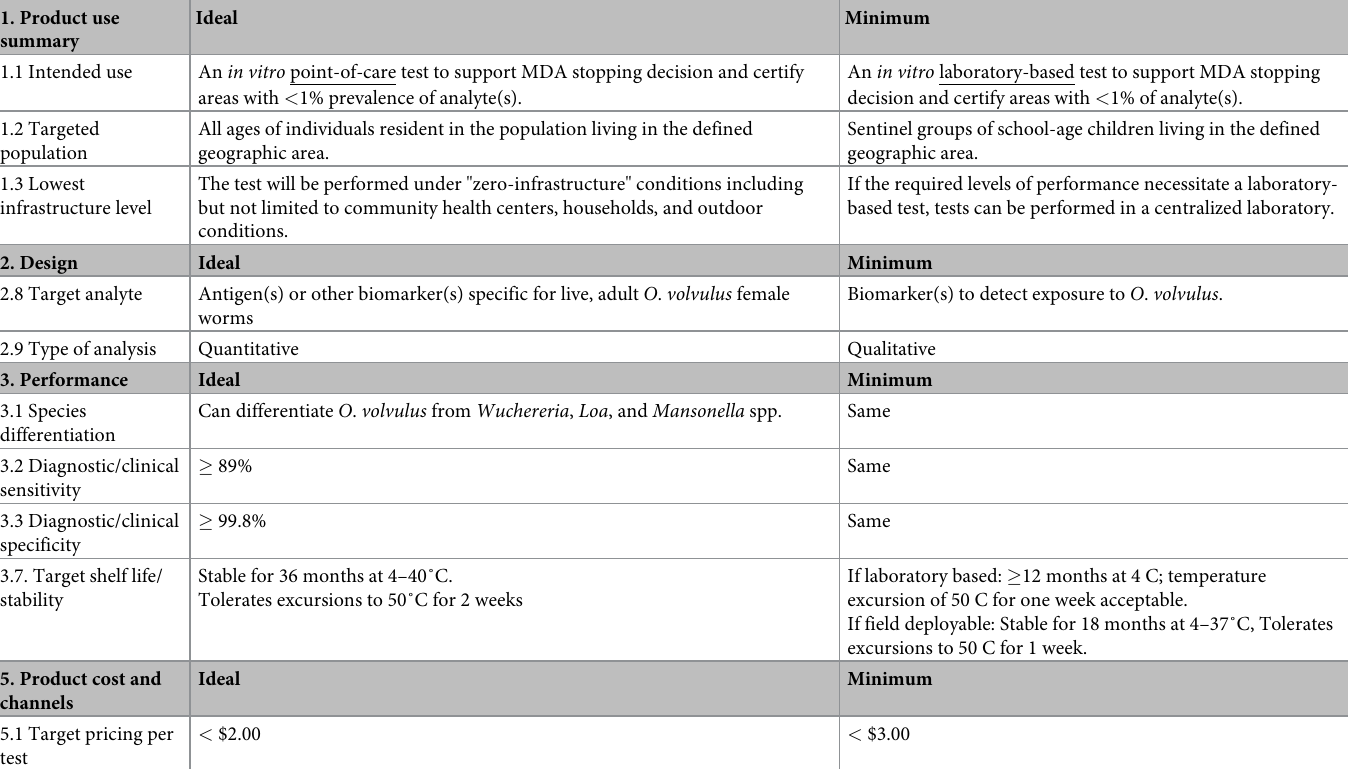
Table 2. Selected features of the target product profile of a diagnostic to support an MDA stopping decision. Criteria that are generally expected of a rapid diagnostic test for a NTD are not included in this summary. For all 41 criteria, please see the original publication [5]. The word “biomarker” includes an